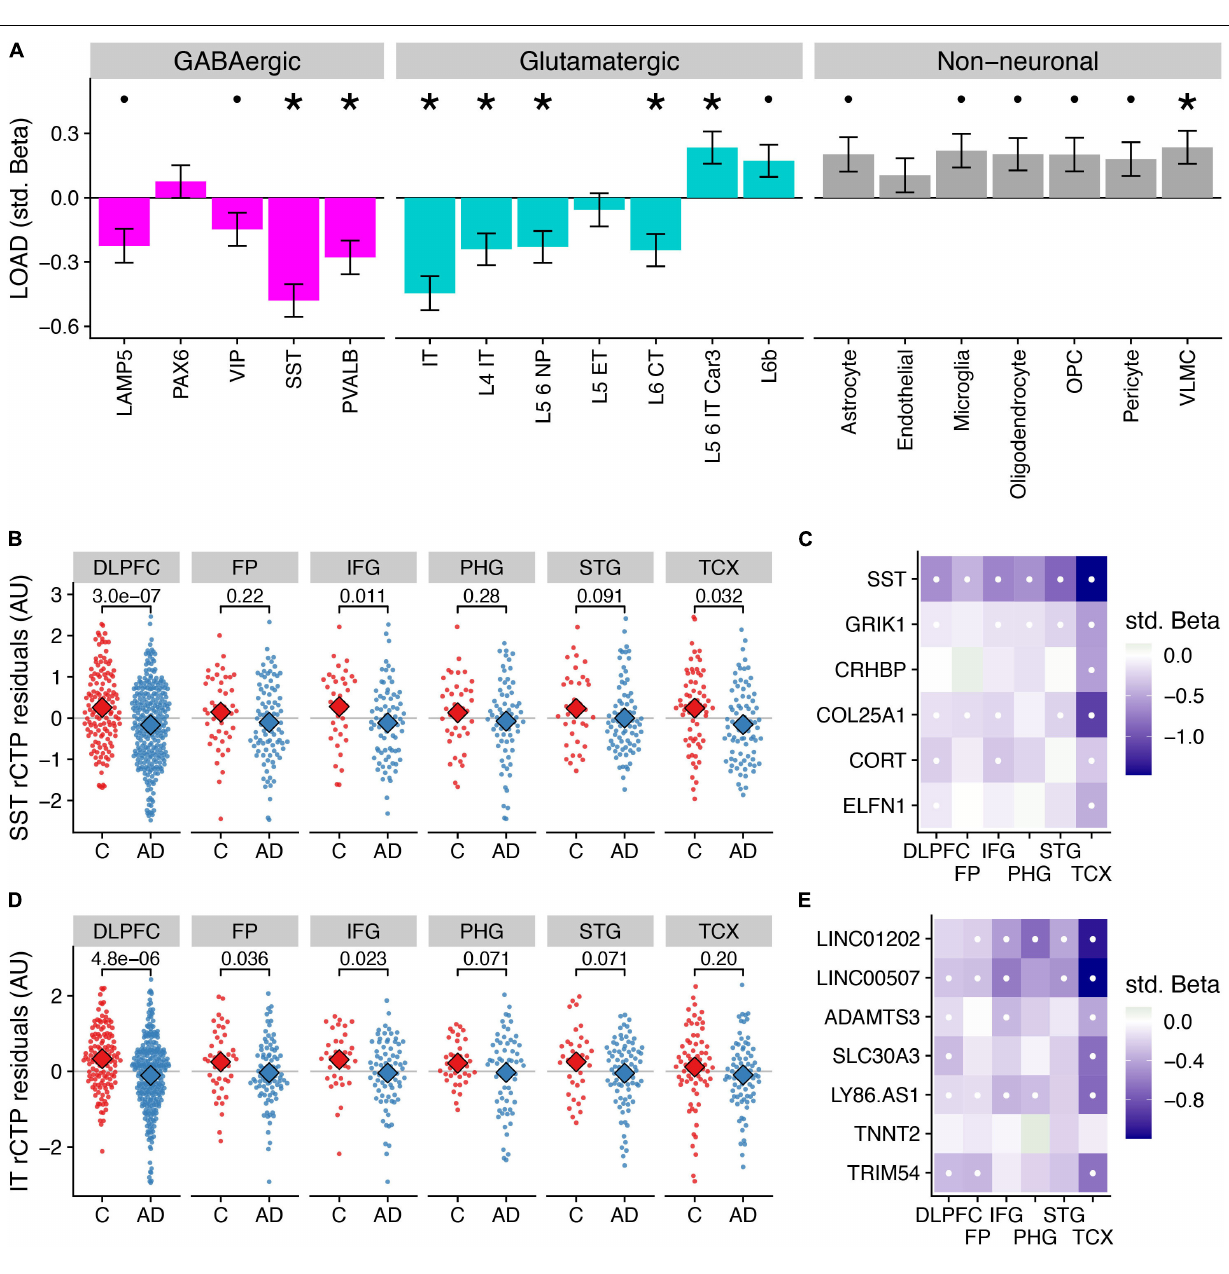
Frontiers in Molecular Neuroscience |